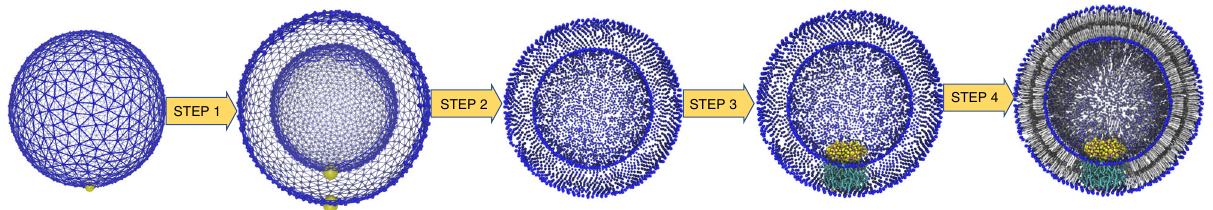
Fig. 1 Overview of TS2CG backmapping scheme. (Step 1) A DTS structure of a vesicle containing one protein (yellow bead) is rescaled and two TS structures corresponding to the two monolayers that are generated. (Step 2) Using a Pointillism operation, the number of vertices is increased. (Step 3) The CG protein structure together with a membrane segment is placed at the appropriate TS position. (Step 4) Lipids are placed at the remaining positions and the con fi guration is ready for subsequent